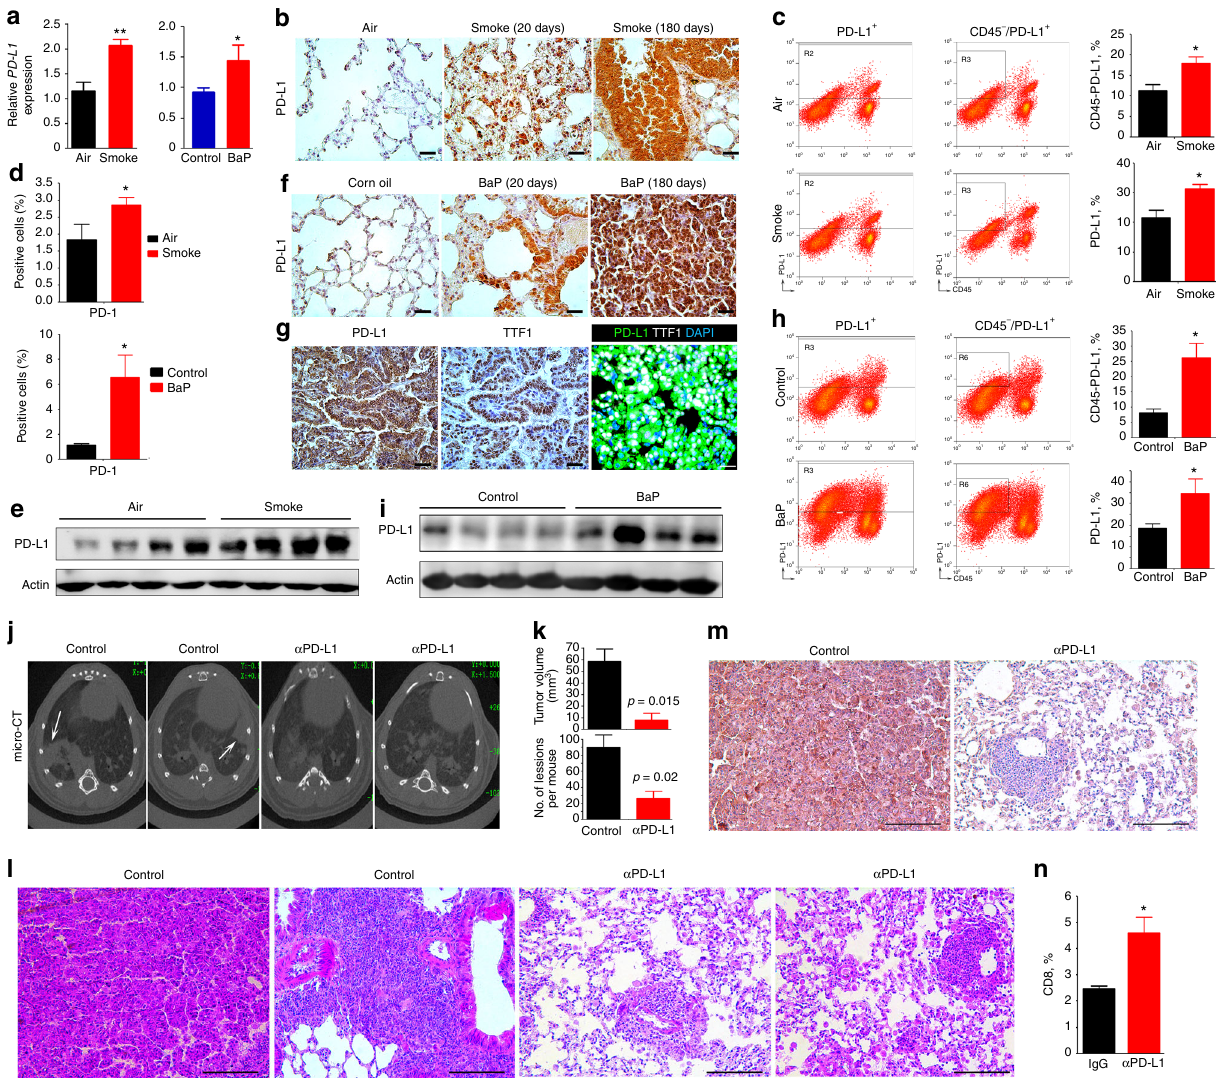
Fig. 2 Tobacco smoke and BaP induce PD-L1 in mice, whereas inhibition of PD-L1 suppresses BaP-induced lung cancer. a The A/J mice were exposed to tobacco smoke or treated with BaP for 20 days and sacri fi ced, the expression PD-L1 in lung tissues was detected by real-time PCR. b The lung tissues were isolated and analyzed by immunohistochemistry using an anti-PD-L1 antibody. Scale bar = 2000 μ m. c, d Flow cytometry analysis of PD-L1 + , CD45 - PD-L1 + cells ( c ) and PD-1 + ( d ) cells in lung tissues of mice exposed to tobacco smoke. PD-1 + cells in lung tissues of mice treated with BaP were also shown ( d ). PD-1 + cells in this experiment were analyzed from the CD45 + CD3 + leukocytes isolated from the same tumor. e The expression of PD-L1 in lung tissues of mice exposed to tobacco smoke was assayed by Western blot. f Lung tissues of BaP-treated mice were isolated and analyzed by IHC assays using an anti- PD-L1 antibody. Scale bar = 2000 μ m. g IHC (left and middle panels) and immuno fl uorescence (right) assays of lung tissues of BaP-treated mice using continuous sections of 5 μ m. IHC assay was conducted using anti-TTF1 and anti-PD-L1 antibodies, and immuno fl uorescence assay was performed using anti-PD-L1 (green) and anti-TTF1 (white) antibodies, and 4,6-diamidino-2-phenylindole (DAPI) to stain the nucleus (blue). IHC assays, scale bar = 2000 μ m; immuno fl uorescence assays, scale bar = 20 μ m. h Flow cytometry analysis of PD-L1 + and CD45 - PD-L1 + cells in lung tissues of mice treated with BaP. i The expression of PD-L1 in lung tissues of BaP-treated mice was assayed by Western blot. j Micro-CT scanning of lungs of BaP-treated mice with or without anti-PD-L1 antibody. k Comparison of tumors in mice of the two groups. l Hematoxylin-eosin (HE) staining of lung sections from BaP-treated mice with or without PD-L1 blockade. Lesions/mouse are shown in (k) . Scale bar = 500 μ m. m IHC assays of lung tumor tissues of BaP-treated mice using an anti-PD-L1 antibody. Scale bar = 500 μ m. n Flow cytometry analysis of CD45 + CD3 + CD8 + (CD8 + ) cells in tumor tissues of mice treated with BaP and anti-PD-L1 antibody. Student ’ s t test, * P < 0.05; ** P < 0.01. Error bars,